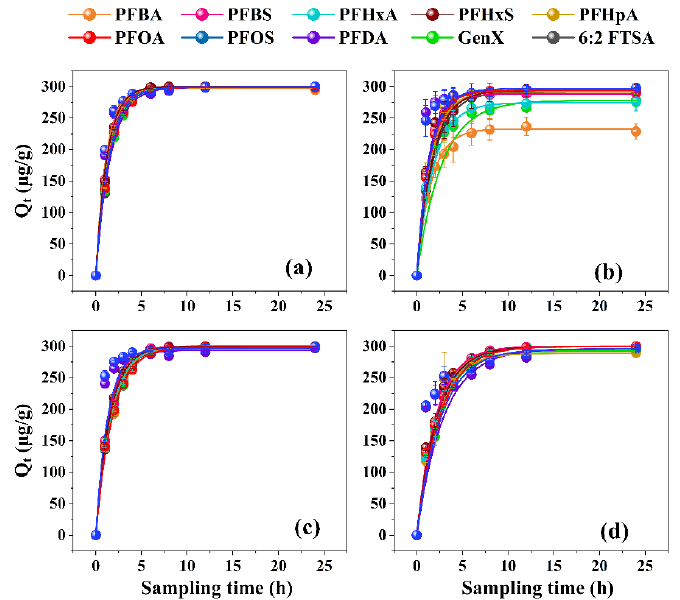
Figure 1. Pseudo-first-order model curve for the adsorption of PFASs onto different resins: ( a )